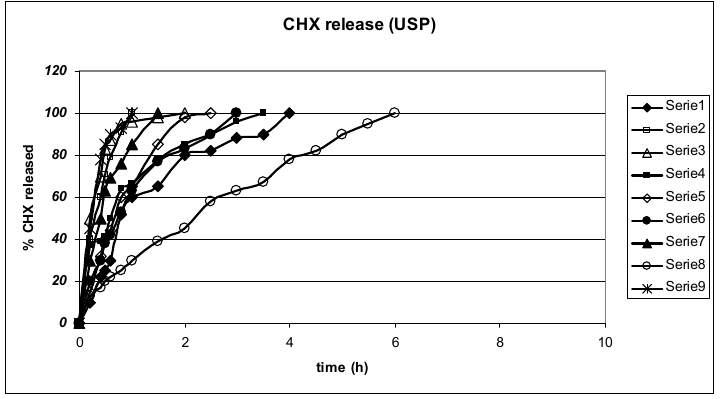
Figure 3. Release profiles according to the new method: the numbers are as in Table